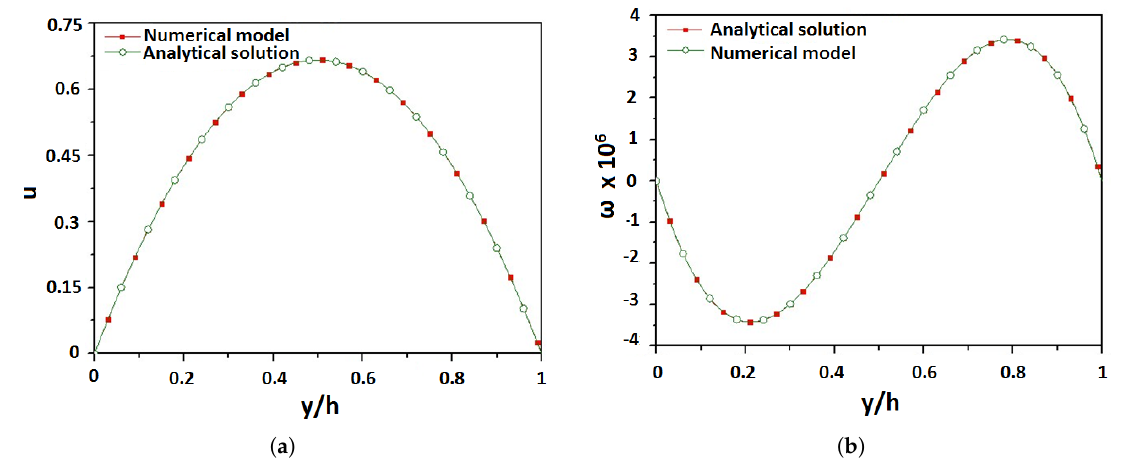
Figure 4. Numerical and analytical results for ( a ) velocity, and ( b ) microrotation for the case G = 2.70, A = 6.53, a = 1.96, h = 0.01 [32].